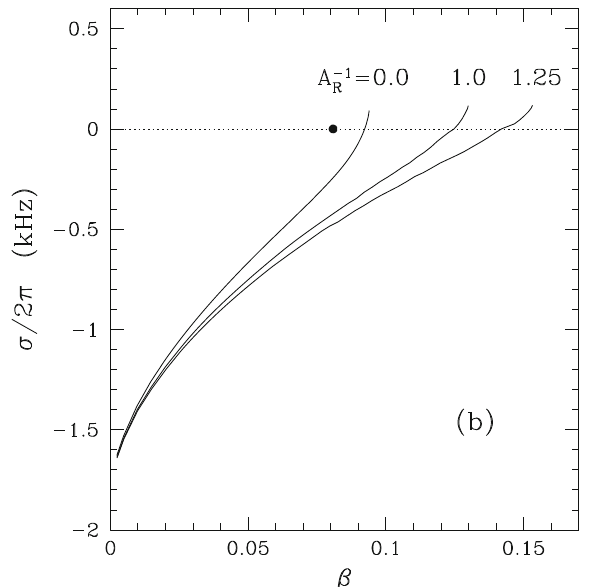
Fig.15 Eigenfrequencies(intheCowlingapproximation)ofthe m = 2modeasafunctionoftheparameter β = T / | W | for three different sequences of differentially rotating neutron stars (the A − 1 corresponding to uniform rotation). The filled circle indicates the neutral stability point of a uniformly rotating star computed in full general relativity (Stergioulas and Friedman 1998). Differential rotation shifts the neutral point to higher rotation rates. (Image reproduced with permission from Yoshida et al. 2002, copyright by AAS)